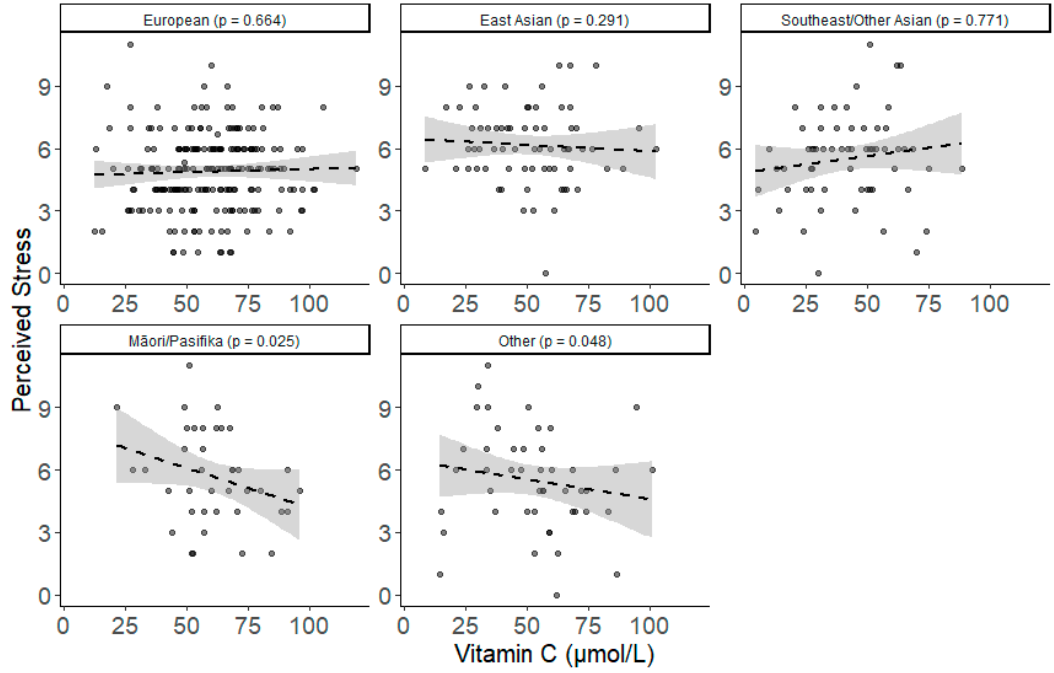
Figure 6. Simple scatterplots of the unadjusted relationship between vitamin C and perceived stress between different ethnic groups (Europeans, East Asians, Southeast/Other Asians, M¯aori/Pasifika and Other). Dashed line indicates the line of best fit. Grey shading indicates 95% confidence intervals. p values for fully adjusted simple slopes.